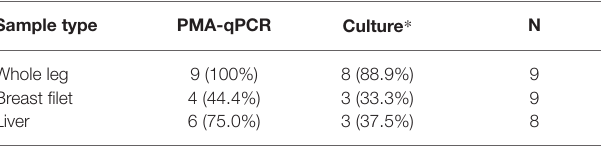
* Detection of Campylobacter spp. was confirmed by direct sequencing using C412F and C1228R primers listed in Table 1 . PMA-qPCR: propidium monoazide treatment combined with quantitative polymerase chain